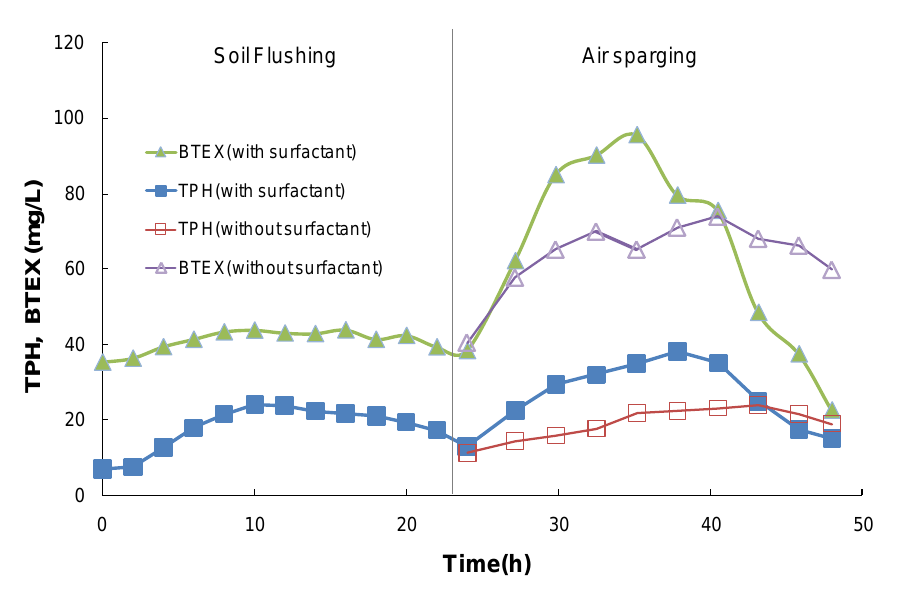
Figure 7. Serial pilot operation of the modified soil flushing and air sparging